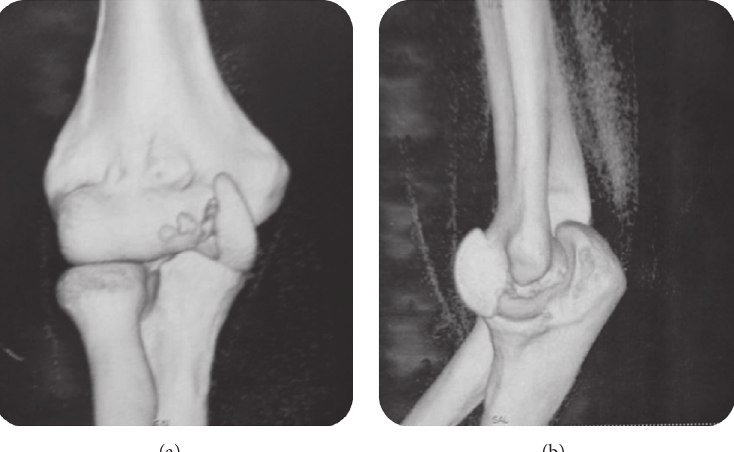
Figure 3: Computed tomography of the elbow with 3D reconstruction showed an isolated shear fracture of the trochlea with no other bony abnormality.